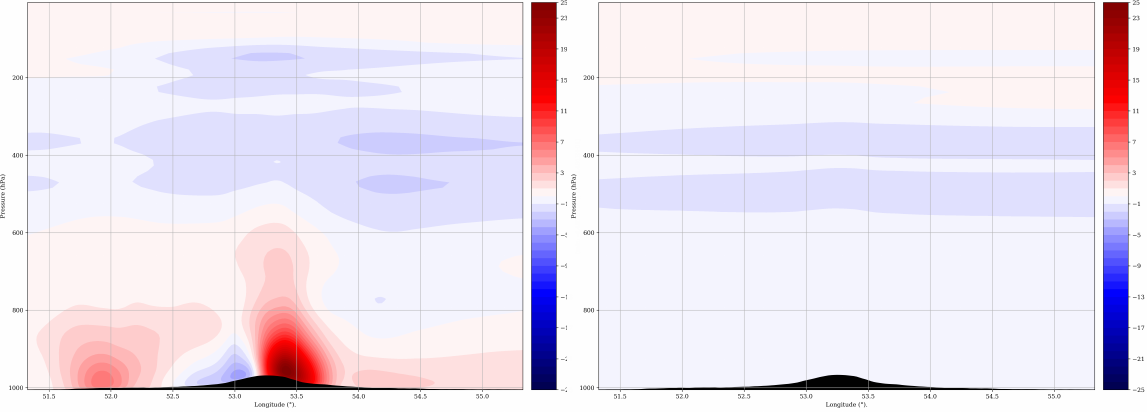
Figure 13. Meridian wind analysis increment on zonal section (51°3 E–55°3 E, 12°2 S) across TC center on 7 February 2019 02:00Z for xp for SAR_12km_2ms ( left ) and NO_SAR ( right ). Units are m · s − 1